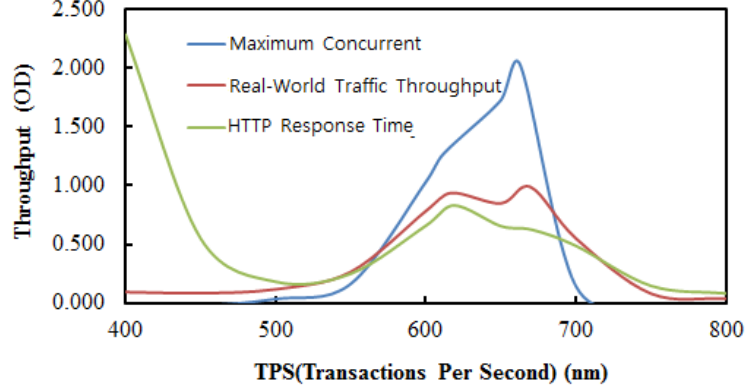
Figure 17. Default smart grid security performance.